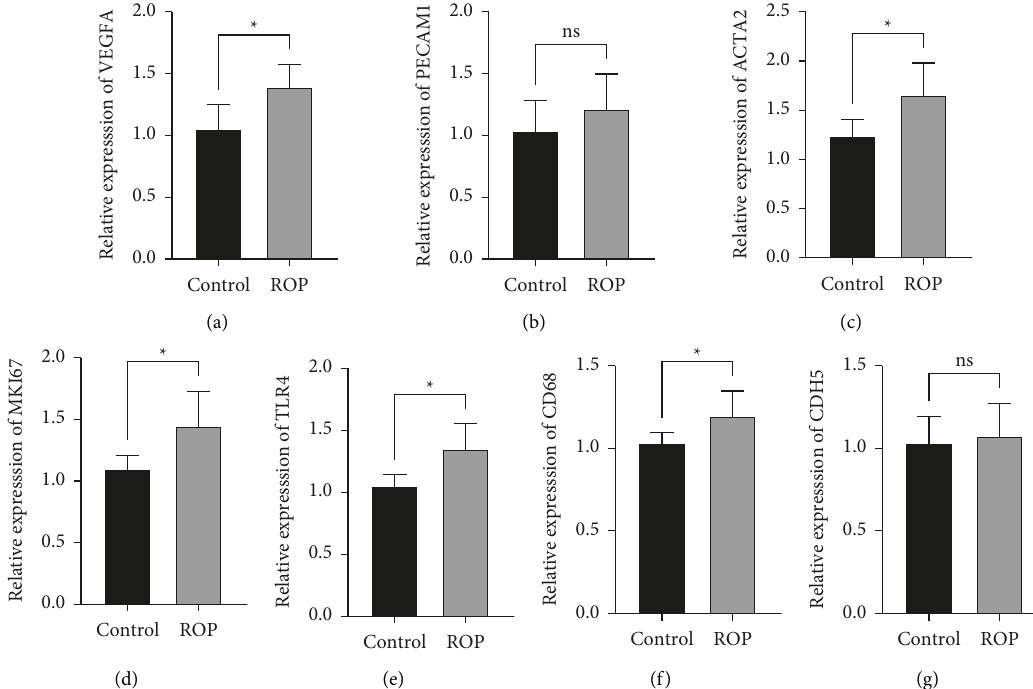
Figure 7: Differential expression of mRNAs in peripheral blood between ROP and control was validated by qRT-PCR. (a) VEGFA, (b) PECAM1, (c) ACTA2, (d) MKI67, (e) TLR4, (f) CD68, and (g) CDH5, ns (no significant difference, P > 0 . 05), ∗ P < 0 . 05, ∗∗ P < 0 . 01, and ∗∗∗∗ P < 0 .